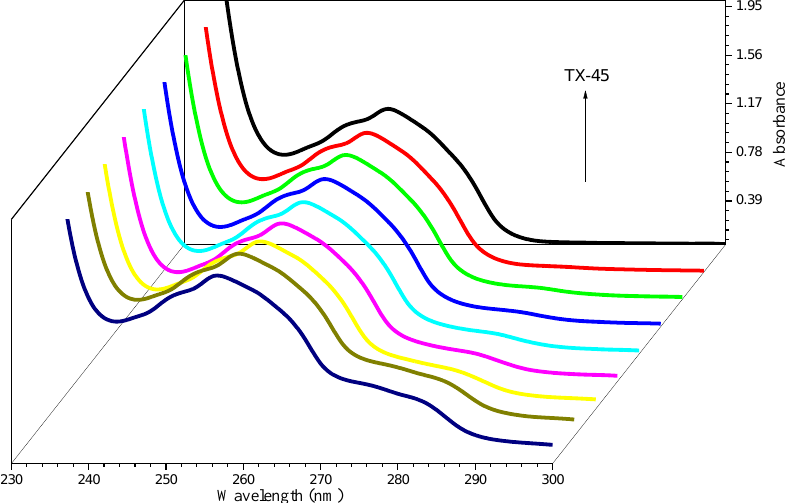
Figure 3. Absorbance spectra of DPH along with rising [TX –